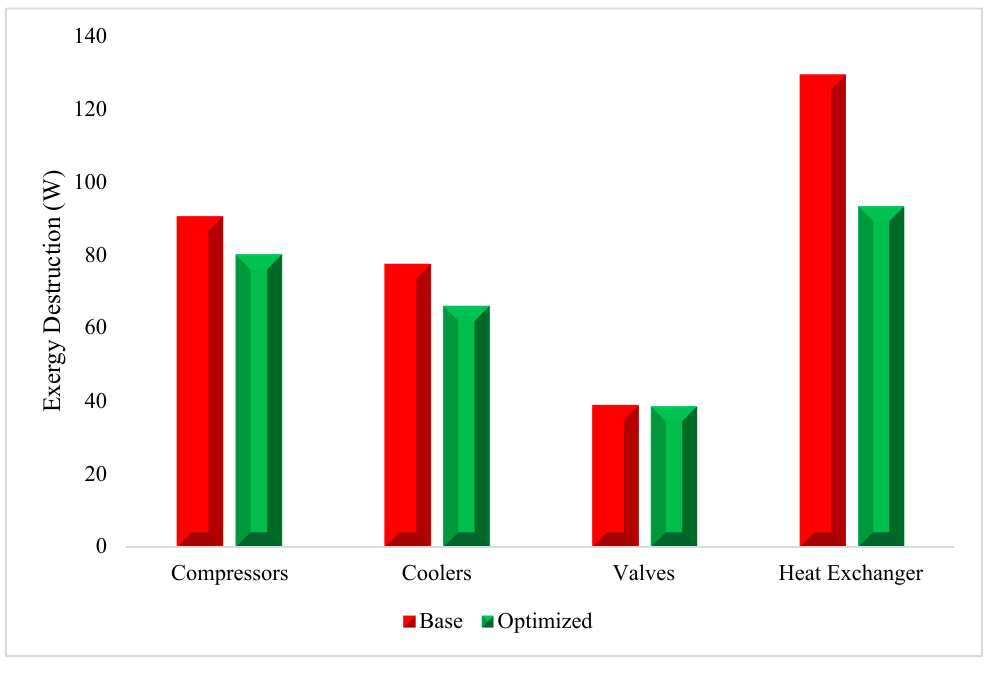
Figure 7. Exergy destruction comparison in SMR LNG process (base and optimized cases).